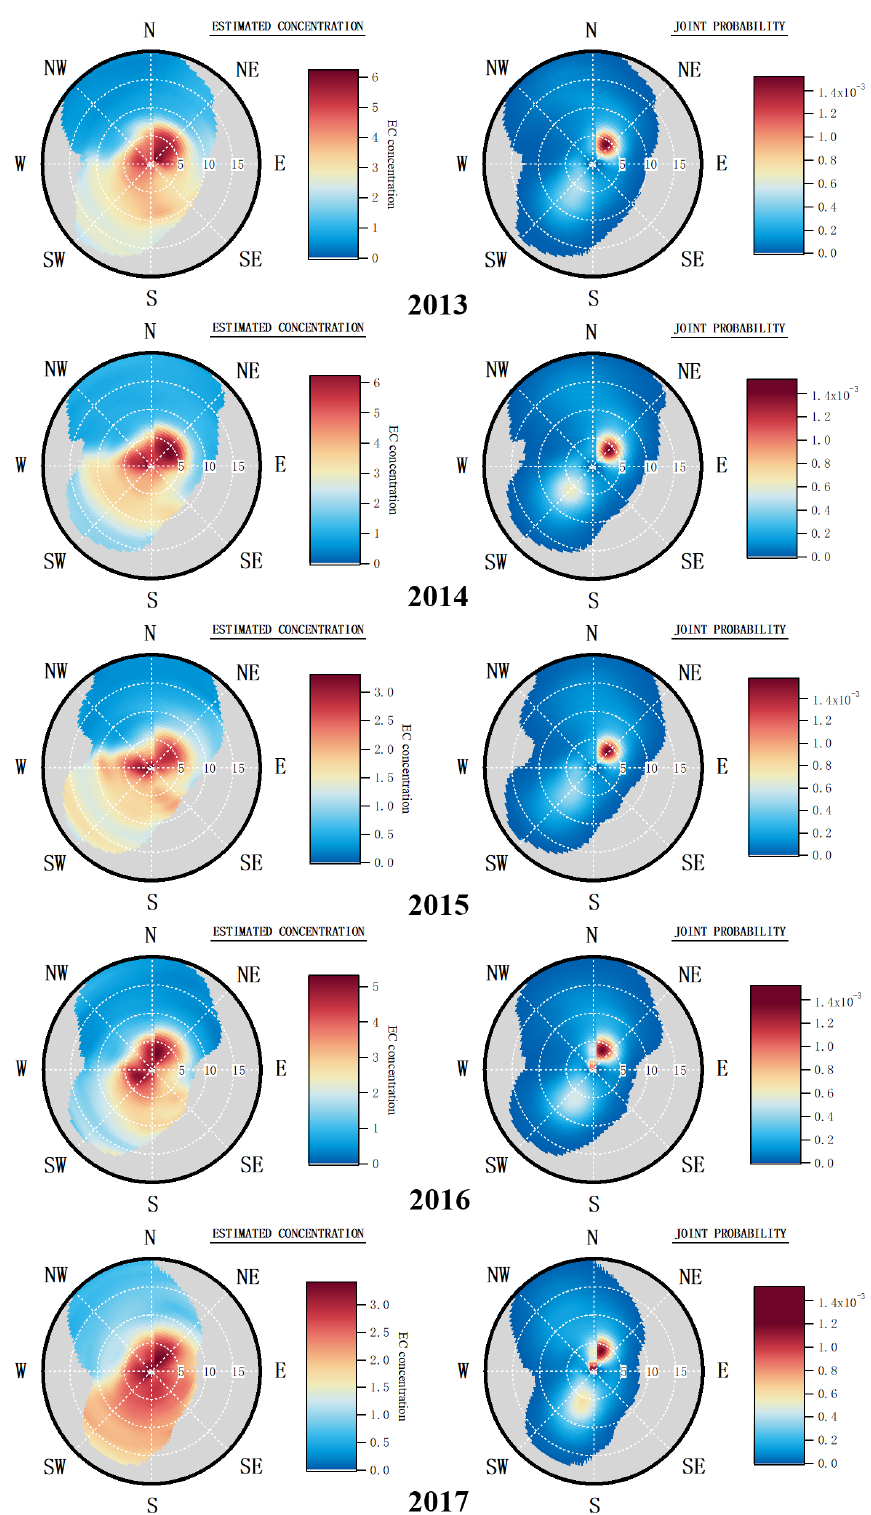
Figure 8. Wind analysis results using NWR on 1h EC concentrations measured in Beijing from 2013 to